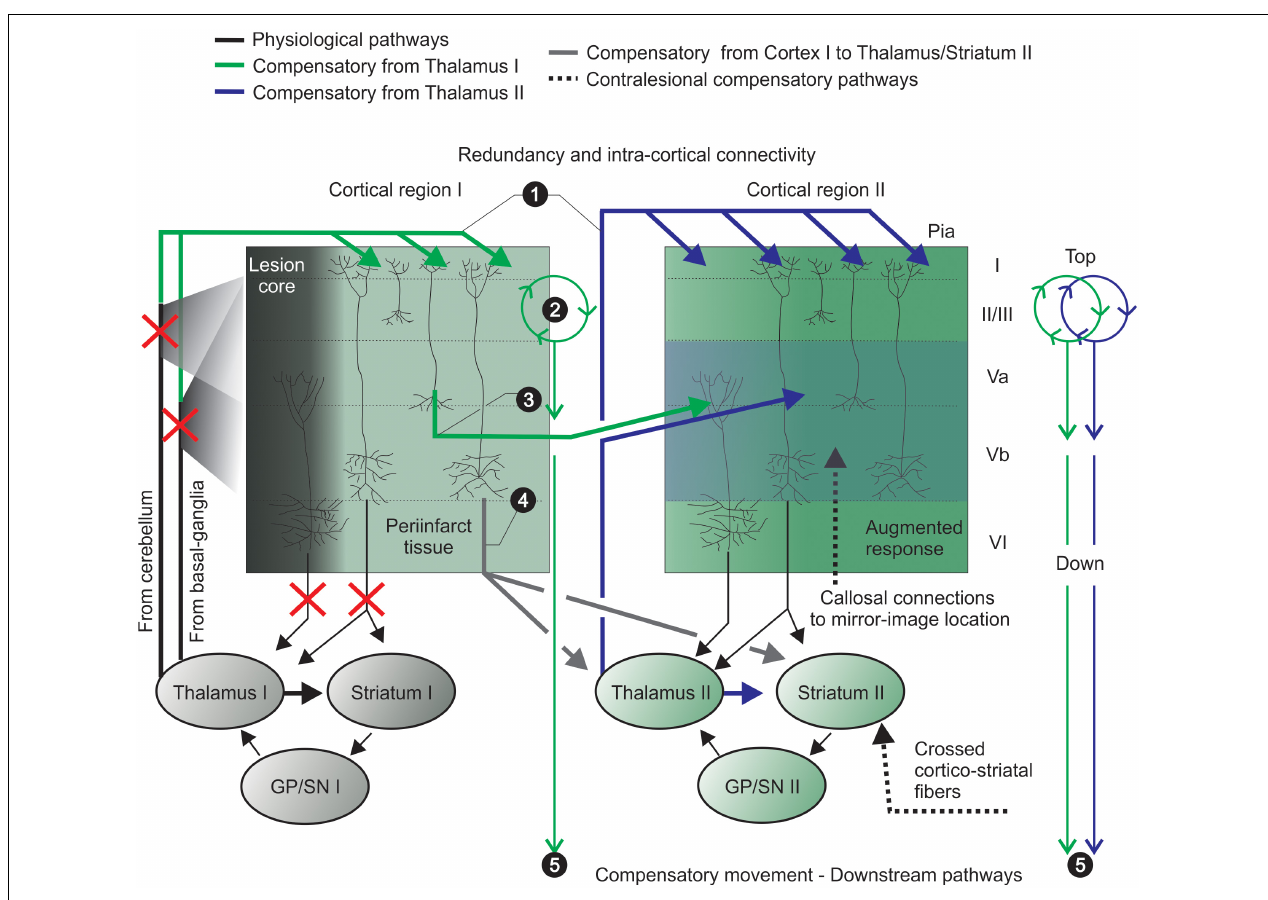
FIGURE 1 | Pronounced intra-cortical connectivity and redundancy are remarkable features of the motor cortex. Motor cortex caudal (e.g., cortical region I) and rostral (e.g., cortical region II) forelimb areas contain the primary motor neurons that encode motor map representations of forelimb skilled movements. Pyramidal neurons project to brainstem and spinal cord (not shown) and send collaterals to striatum and thalamus – integrating thalamo-cortico-thalamic and thalamo-cortico striatal loops. (1) widespread thalamo-cortical connections common to both cortical regions (I and II) target superficial layers and reach damaged, periinfarct and spared areas (upper green and blue solid lines); (2) the preamplifier-like network (green circular loop) captures thalamic I signals and drives output neurons in lower layers (Weiler et al., 2008); (3) horizontal cortico-cortical connections of neurons receive and retransmit this indirect thalamic information (previously shared with the infarct core area) (green solid lines); (4) cortico-thalamic and cortico-striatal projections (from cortical region I to II; gray solid line) integrate another striatal-thalamo-cortical loop (cortical region II). The putative participation of crossed cortico-striatal and cortico-cortical fibers is shown (hashed black lines, bottom right). (5) Cells from adjacent/spared tissue (cortical region II) share thalamo-cortical inputs with interconnected/intertwined thalamo-cortical circuits of the stroke-disrupted network to control compensatory relearning of movements. GP, globus pallidus; SN, substantia nigra.